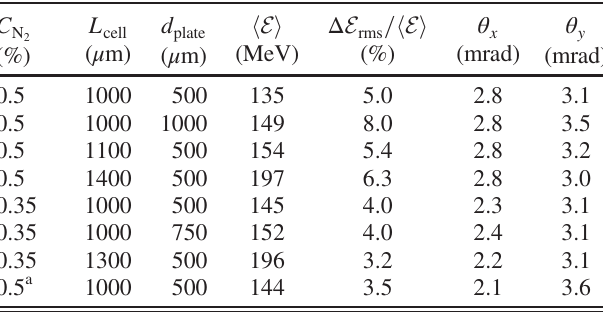
TABLE II. Beam properties for C plate aperture thickness d L ¼ 1000 ; 1100 ; 1300 ; 1400 μ m. The beam properties are cell average energy h E i , rms energy spread Δ E divergence θ x;y